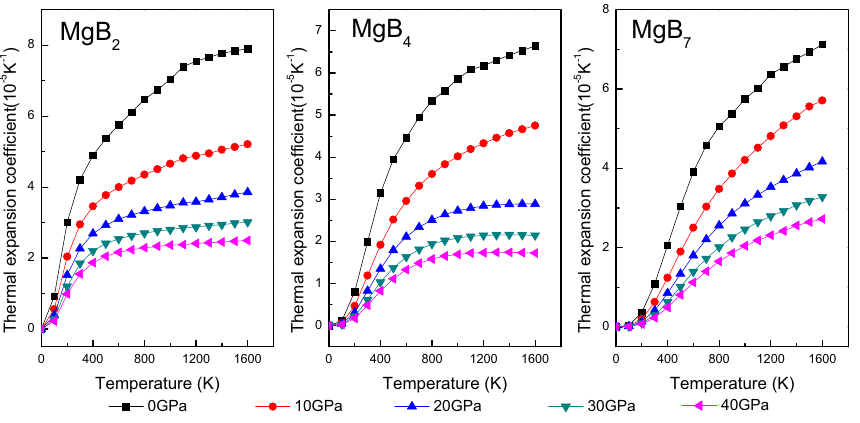
Figure 10. Thermal expansion coefficient of Mg–B compounds as function of pressure and